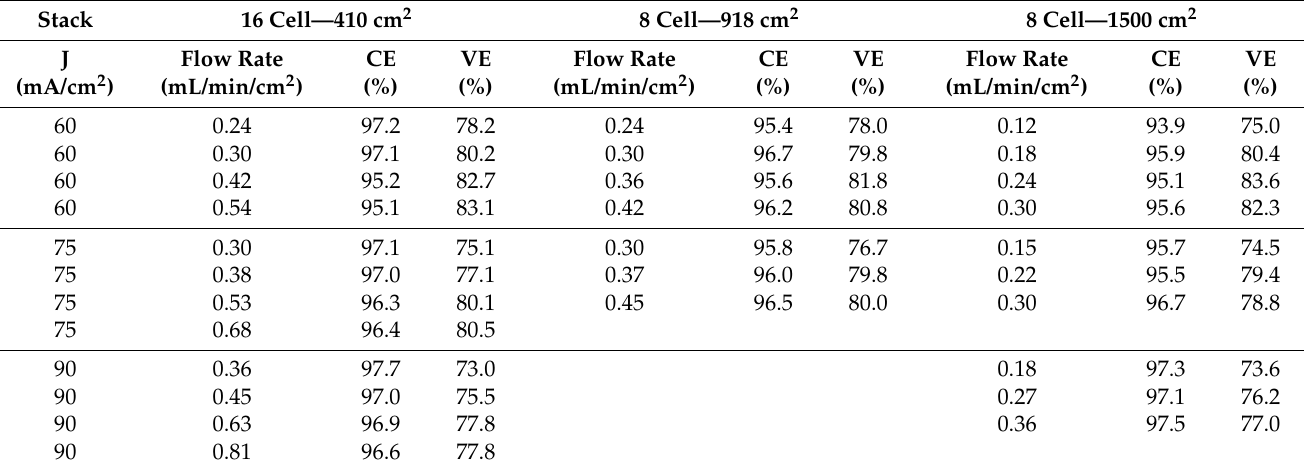
correspond to energy efficiency, without considering the pumping power losses. Table 3. Coulombic efficiency (CE) and voltaic efficiency (VE) of the life cycles of stacks operated at various fixed current densities (J) and flow rates.